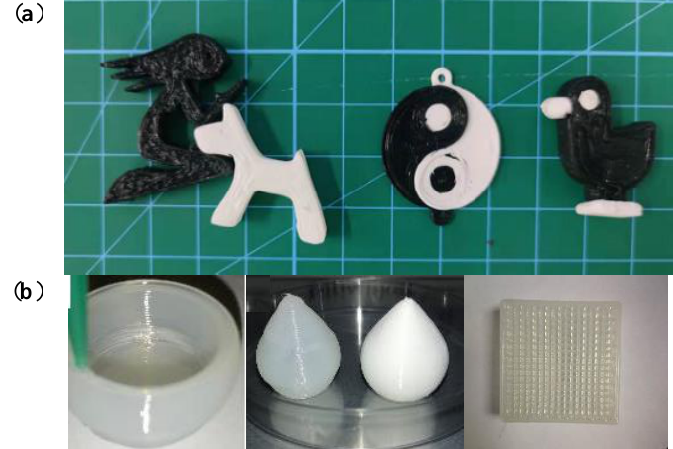
Figure 7. ( a ) Complex 2D structures printed with exemplary silicones; ( b ) complex 3D structures printed with exemplary silicones.